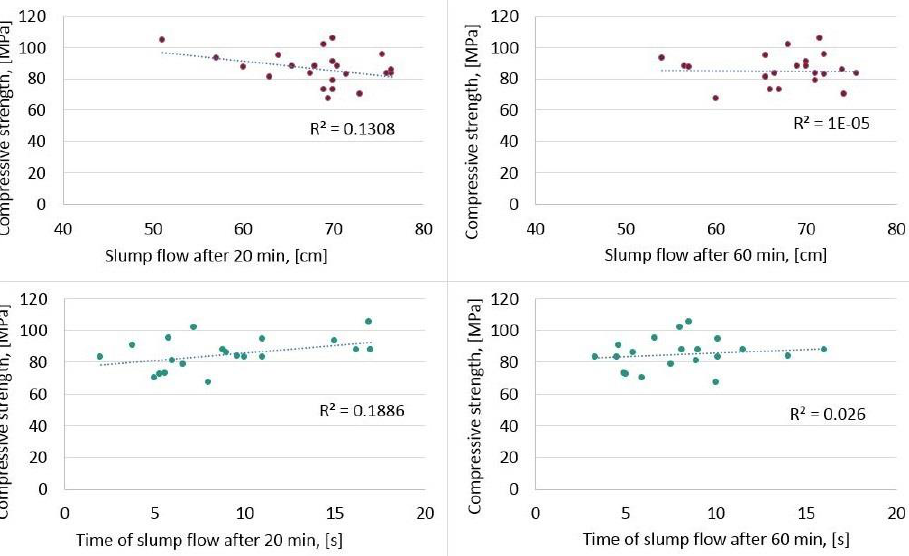
Figure 10. Poor correlation between compressive strength after 28 days and rheological properties: slump flow, D (cm) and time of slump flow, T (s).